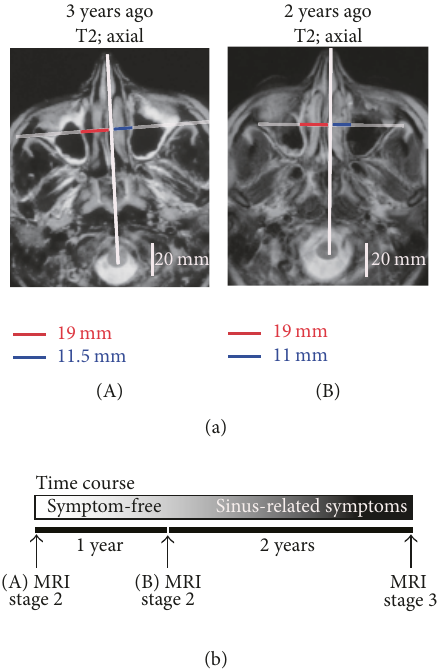
Figure 2: Magnetic resonance images taken 3 and 2 years before the development of ocular manifestations. (a) Magnetic resonance image (MRI) findings: (A) the T2 axial view of MRI 3 years before the ocular presentation; (B) the T2 axial view of MRI 2 years before the ocular presentation. Both images show that the medial wall of the right maxillary sinus is deviated compared to the medial wall of the left maxillary sinus. Similar anatomical changes are observed. Thus, 3 and 2 years before ocular manifestations appeared, the distances from the center line to the most deviated medial wall of the right maxillary sinus were 19 and 19mm (red lines), respectively. By contrast, the distances from the center line to the most deviated medial wall of the left (unaffected) maxillary sinus were 11.5 and 11mm (blue lines), respectively. Both situations indicate stage II disease. (b) Time course of the CMA patient. The first MRI was performed 3 years before ocular symptom presentation (A). The second MRI was performed 2 years before ocular symptom presentation (B). The patient did not present with any sinusitis-related symptoms before or at the first (A) and the second (B) MRI. However, in the 2 years following the second MRI, the patient frequently presented with sinus-related symptoms. At the end of that period, the patient was diagnosed with stage III